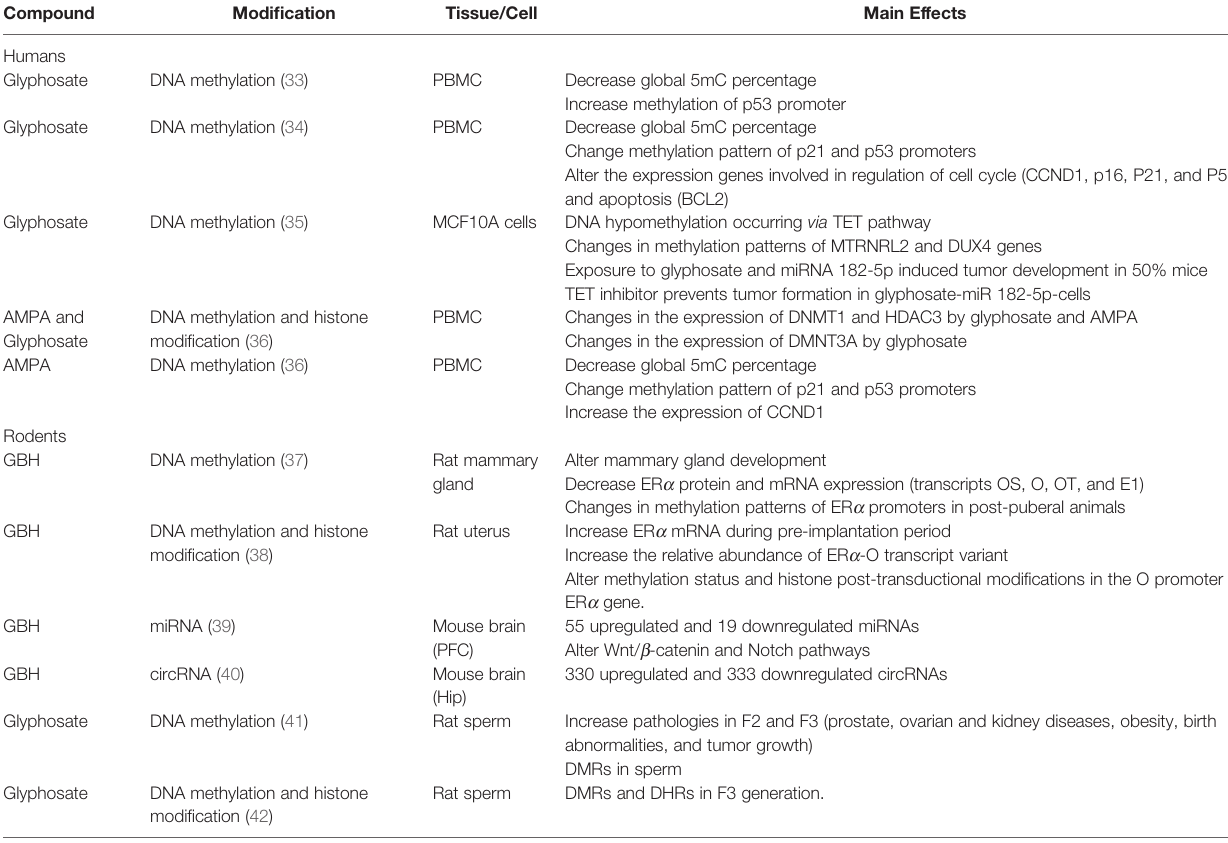
TABLE 1 | Epigenetic modi fi cations induced by glyphosate, glyphosate-based herbicides (GBH) and amino methylphosphonic acid (AMPA).